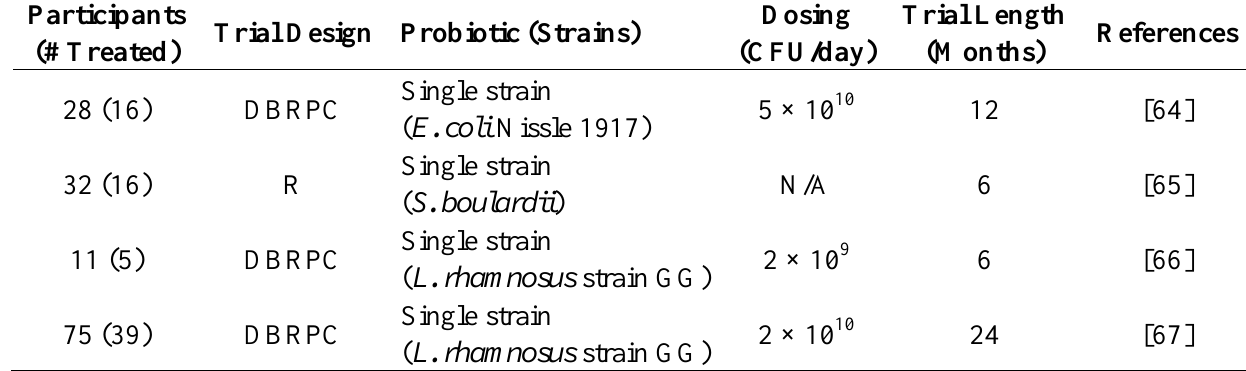
Table 4. Randomized trials of probiotics in Crohn’s disease